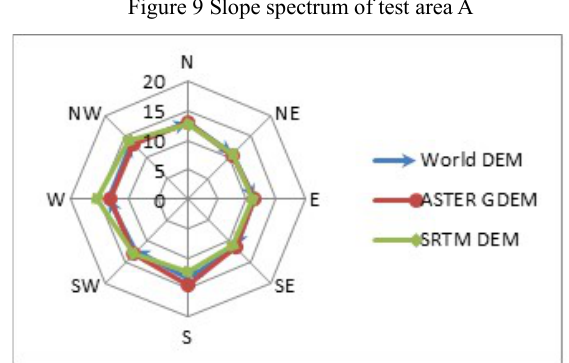
Figure 9 Slope spectrum of test area A